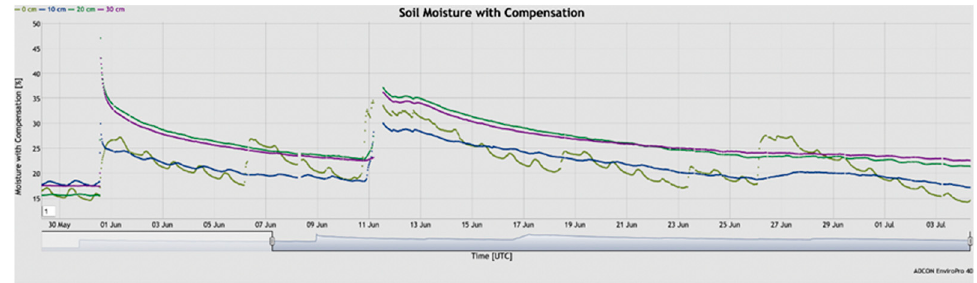
Figure 6. Soil moisture measurements in May and June 2022 in Sadovo, Bulgaria.